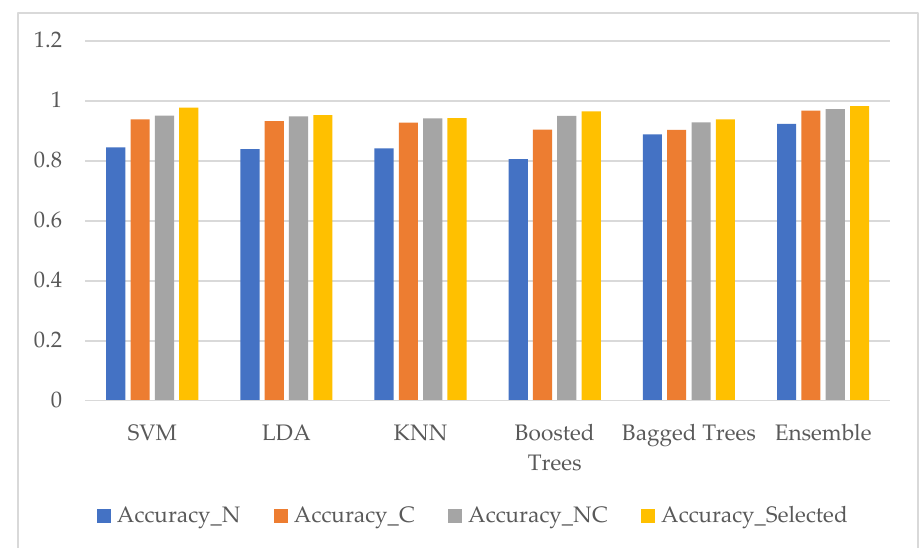
Figure 14. Classification performance of five classifiers and our ensemble classifier in terms of accuracy using four datasets (nuclei features only (Accuracy_N), cytoplasm features only (Accuracy_C), combining nuclei and cytoplasm features without features selection method (Accuracy_NC), and with features selection method (Accuracy_Selected)). (SIPaKMed dataset for the two-class problem).